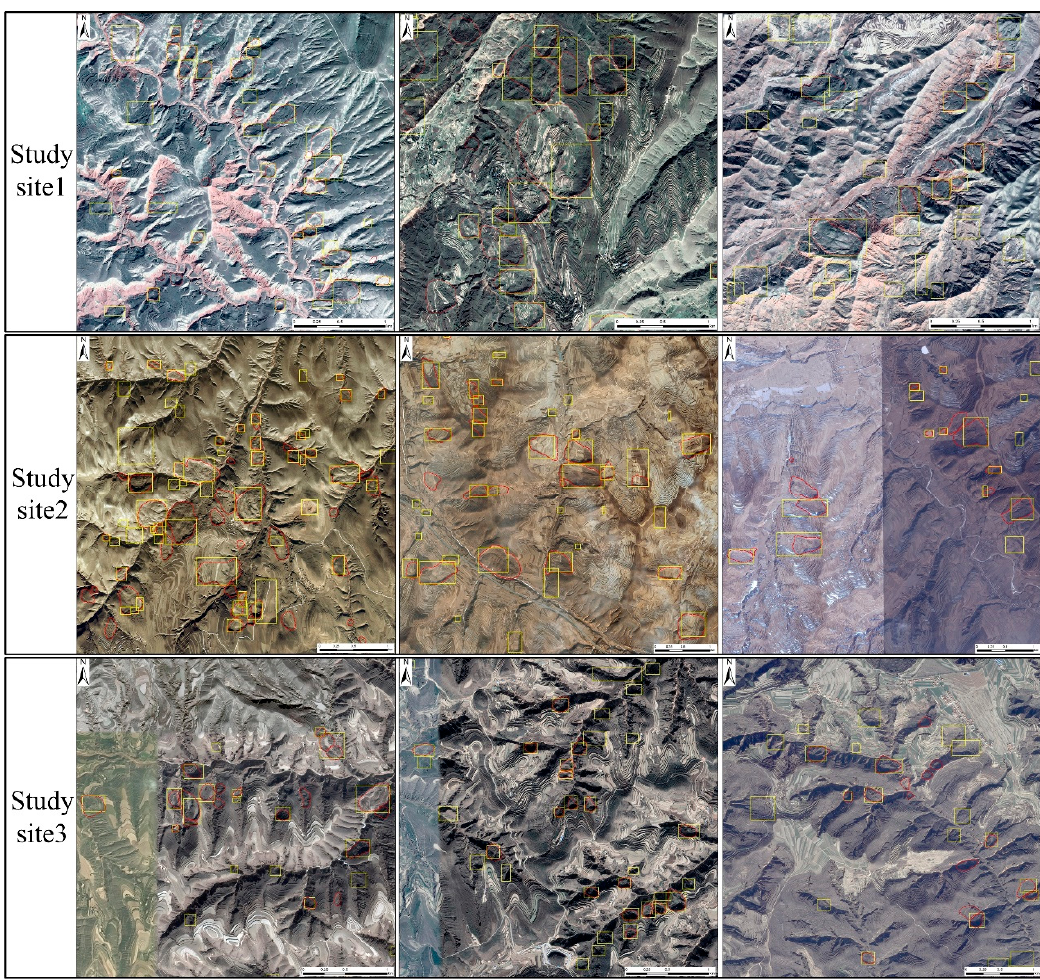
Figure 6. Landslide detection results of the mask R-CNN model against different study areas. Table 3. Recall, precision, and F1-score of Mask R-CNN model against different study